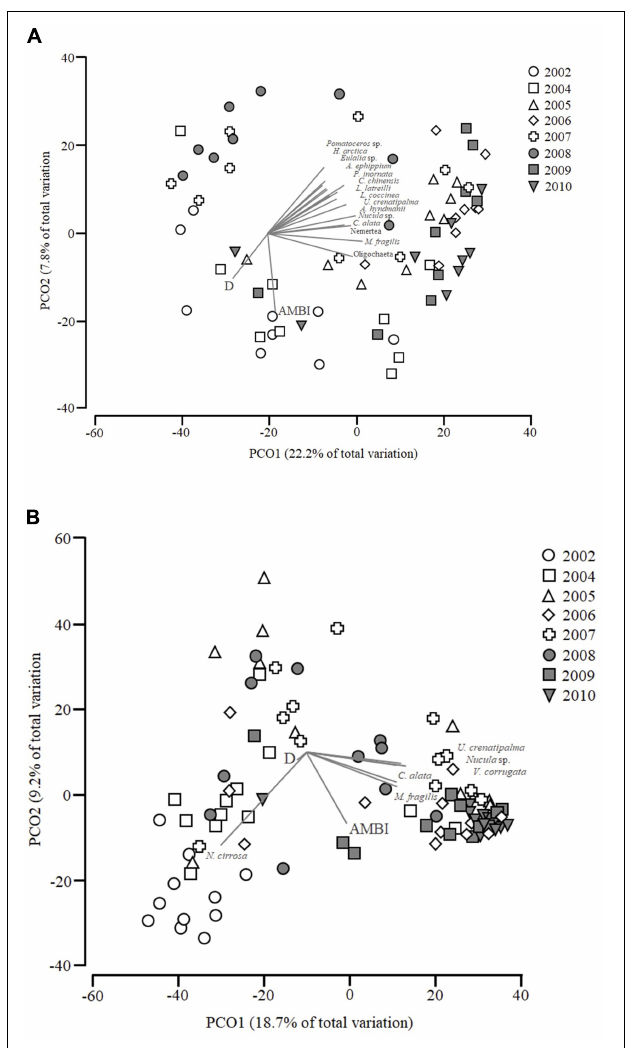
FIGURE 4 | (A) Principal Coordinates Analysis (PCoA) of soft bottom macrobenthic communities within Porto Buxo (PB). Correlations with AZTI’s Marine Biotic Index (AMBI) and Geographic Distribution (D) are represented as overlaid vectors as well as species with Pearson correlation > 0.5 with both axes. (B) PCoA of soft bottom macrobenthic communities within Portinho da Costa (PC). Correlation with AZTI’s Marine Biotic Index (AMBI) and Distribution (D) are shown as well as species which have a Pearson correlation of at least 0.5 with PCO1 or PCO2.